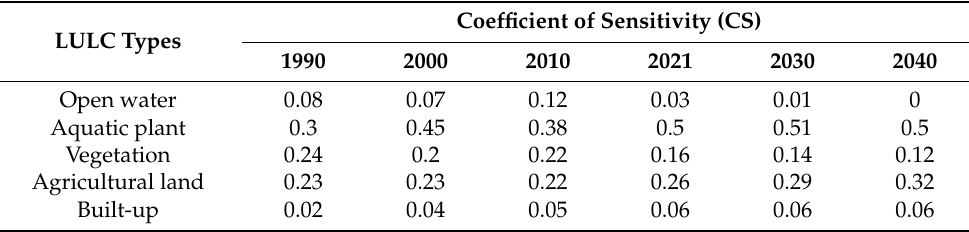
Table 13. Coefficient of sensitivity (CS) value of different LULC classes based on Costanza et al.’s (2014) ESV